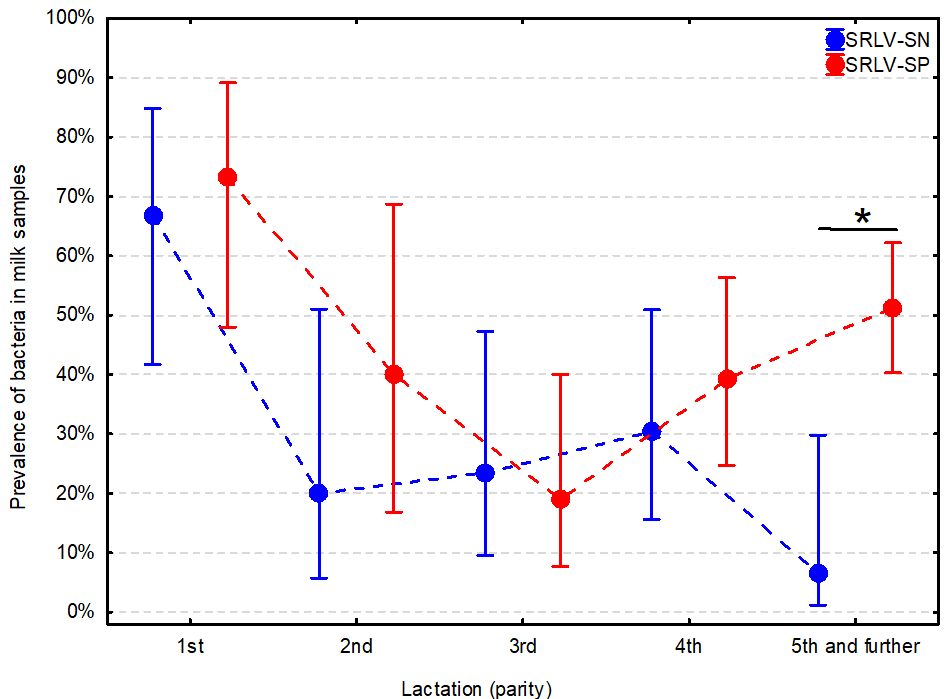
Figure 2. Prevalence of bacteria in milk samples from small ruminant lentivirus-seropositive (SRLV- SP) and seronegative (SRLV-SN) goats in subsequent lactations. Whiskers indicate CI 95% and the asterisk (*) indicates statistical significance at α = 0.05.